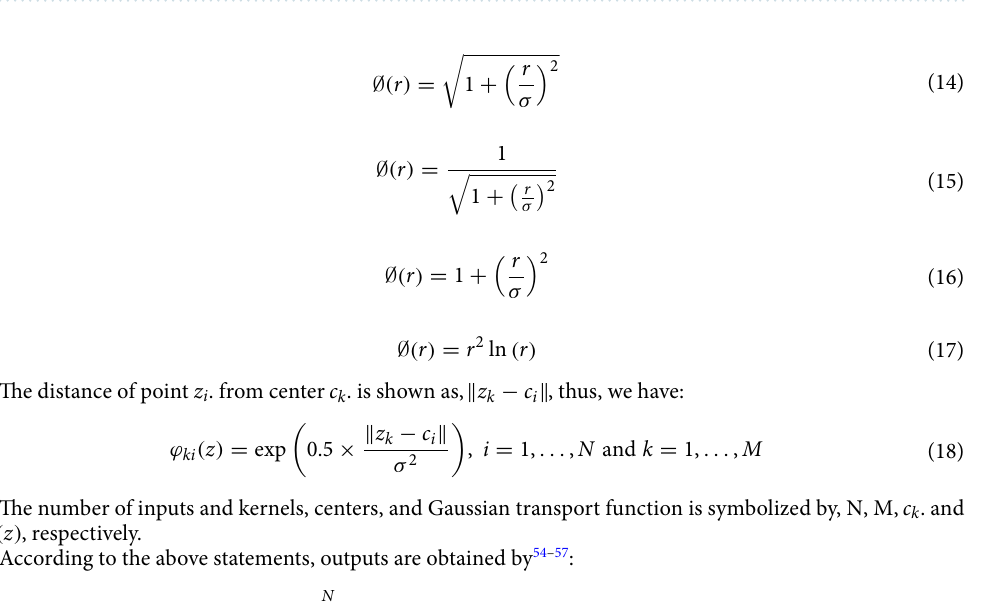
Figure 3. The schematic diagram of